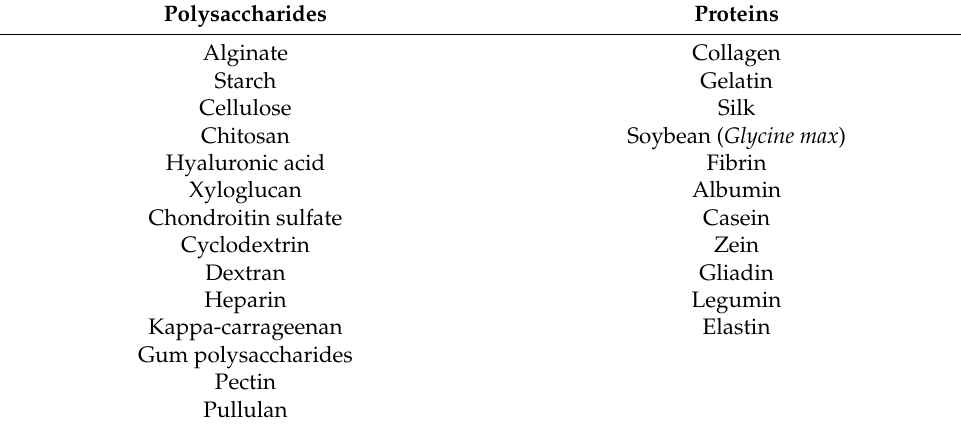
Table 1. Natural polymer classification according to chemical structure [88,89].